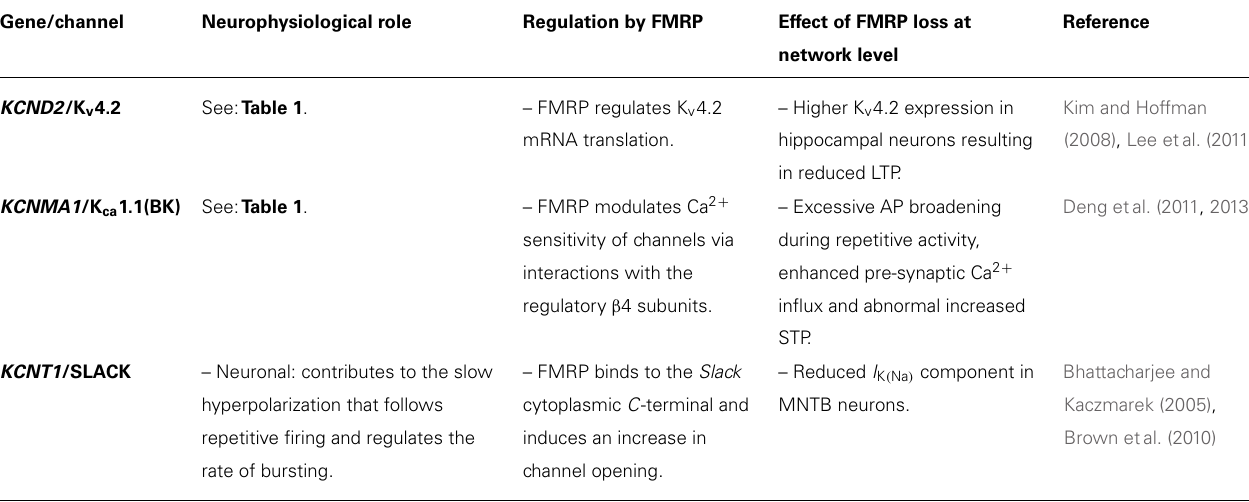
Table 2 | Indirect involvement of K + channels